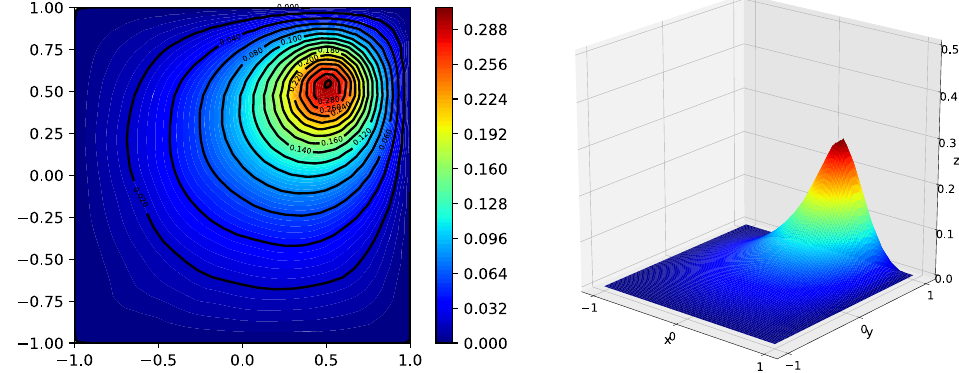
Figure 2. Estimated field function ˆ u outputs from the local filter on S 20 using Algorithm 1. The left figure shows ˆ u in the two-dimensional perspective with contour lines; the right figure shows ˆ u in the three-dimensional perspective.